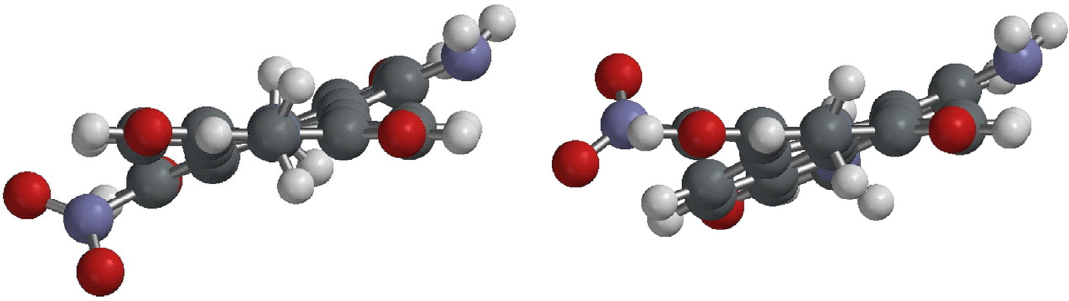
Figure 5. DFT (B3LYP/6-31G**) geometry-optimized structures of 1,6- C (left) and 1,7- C (right) shown with view along the long axis. For computational purposes, methyl groups replace the cyclohexyl groups at the imide